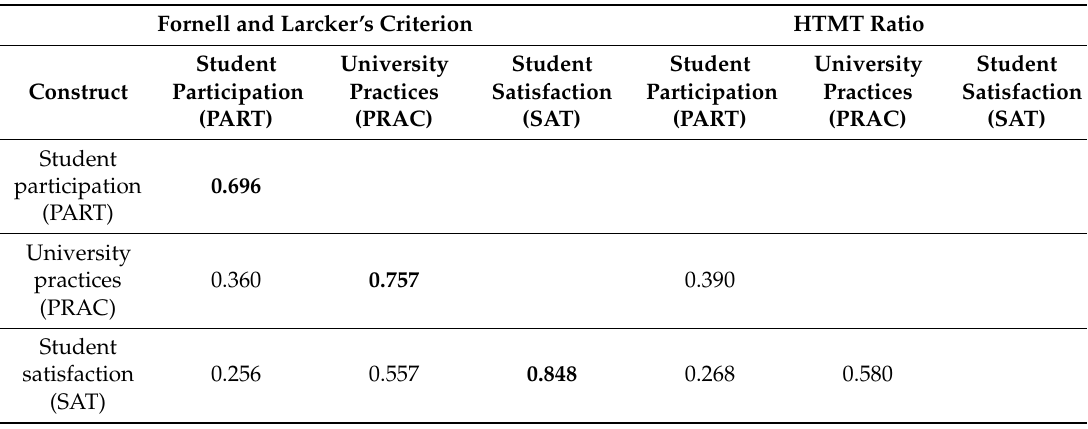
Table 7. Discriminant validity of